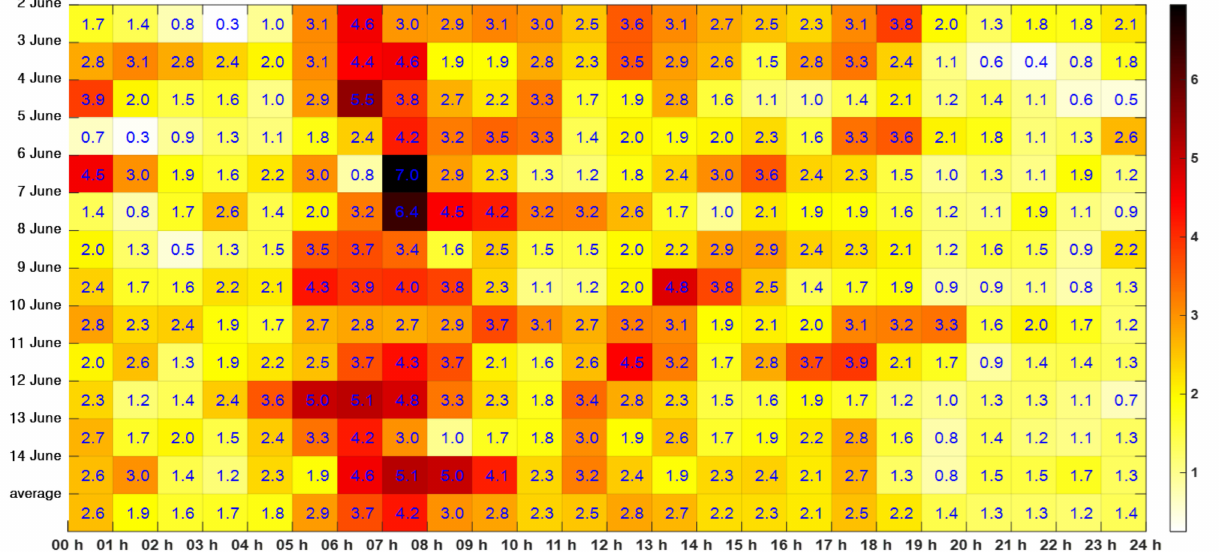
Figure 6. Required hourly number of workstations for Yeosu